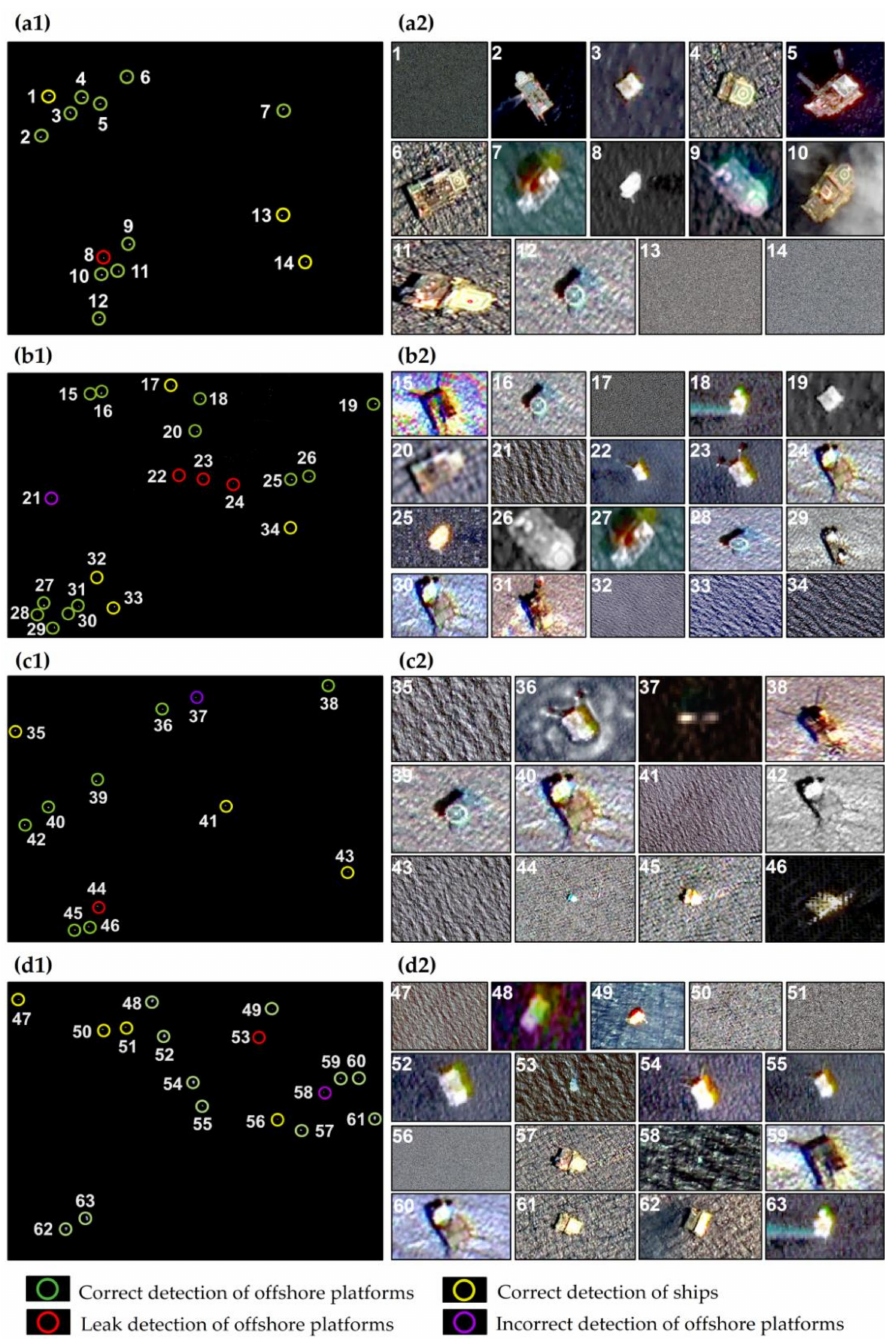
Figure 8. Comparison and analysis results with the GF-1/2 imagery. ( a1 – d1 ) show the detection results and ground truth data of study areas 1–4; ( a2 – d2 ) show the results of comparison and verification with GF-1/2 for study areas